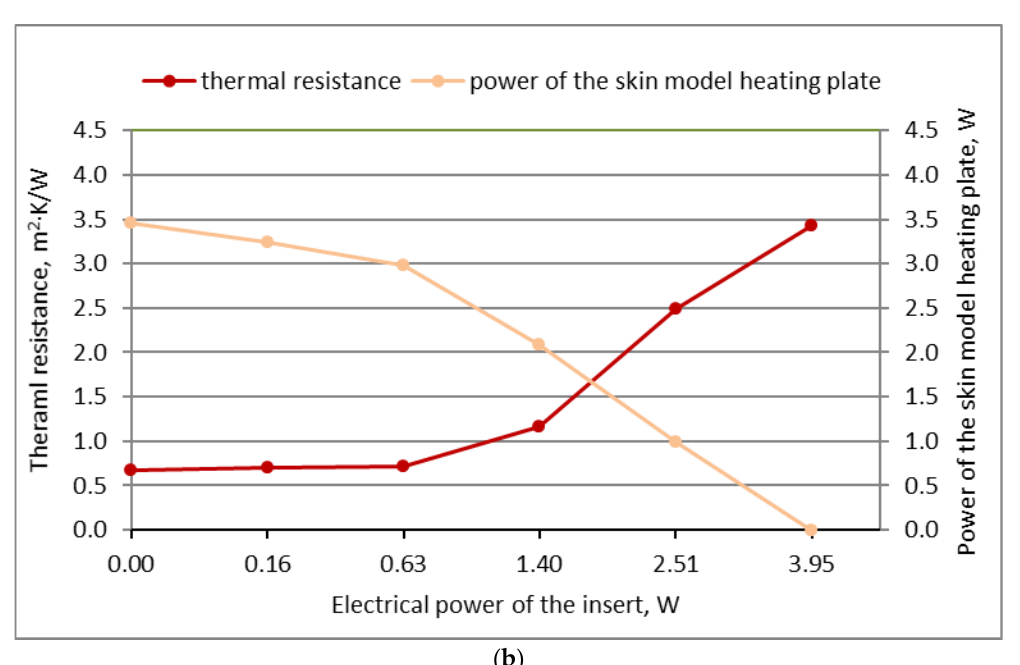
Figure 12. Test results for the system of materials with heating insert B (system: U1 + insert B + Z4 + W2 at − 30 °C: ( a ) temperature changes between the layers of the system depending on the power of the heating insert, ( b ) a graph of the dependence of the thermal resistance of the system with the heating insert and that of the power of the “skin model” measuring plate on the power of the heating insert.